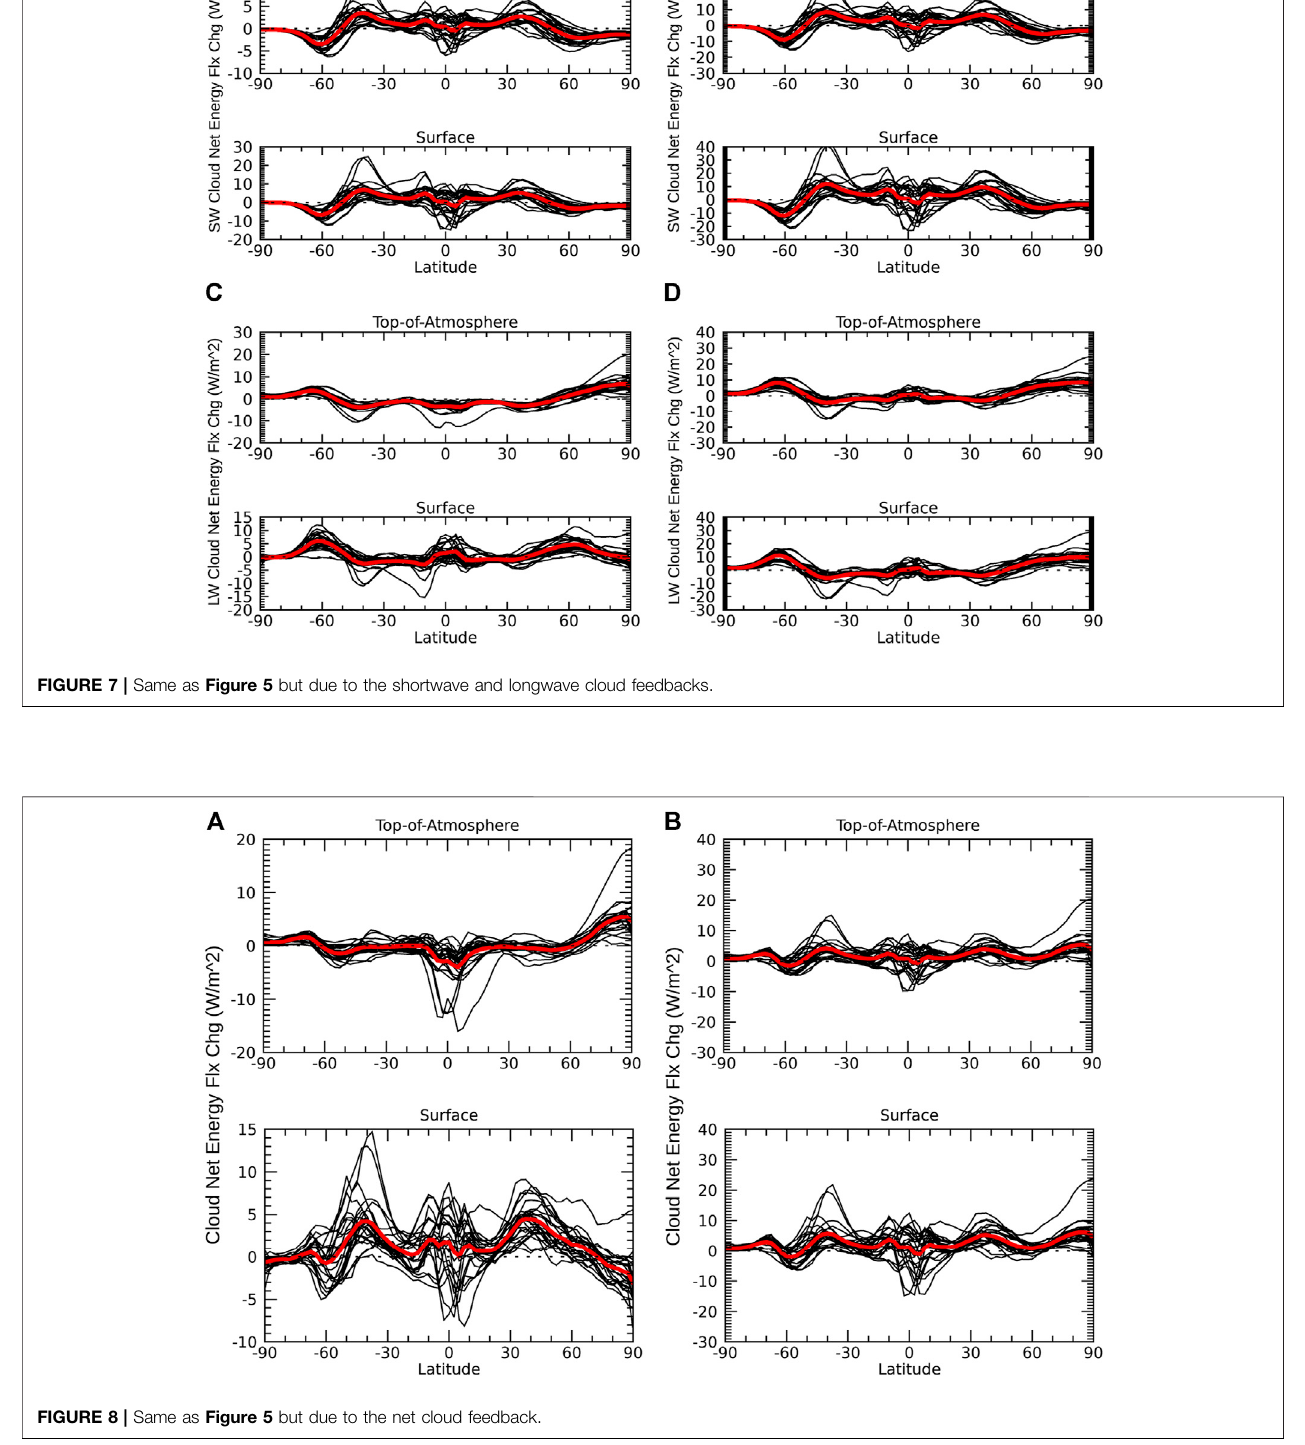
Frontiers in Earth Science |